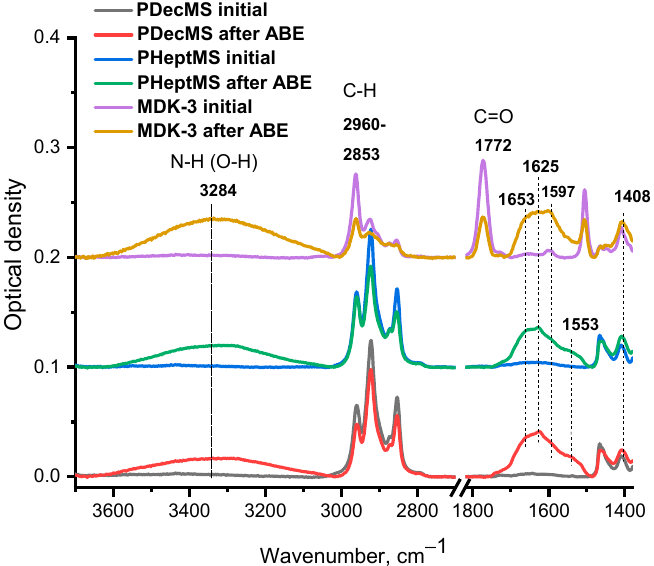
Figure 7. IR spectra of the membranes in the region of 3700–1400 cm − 1 .